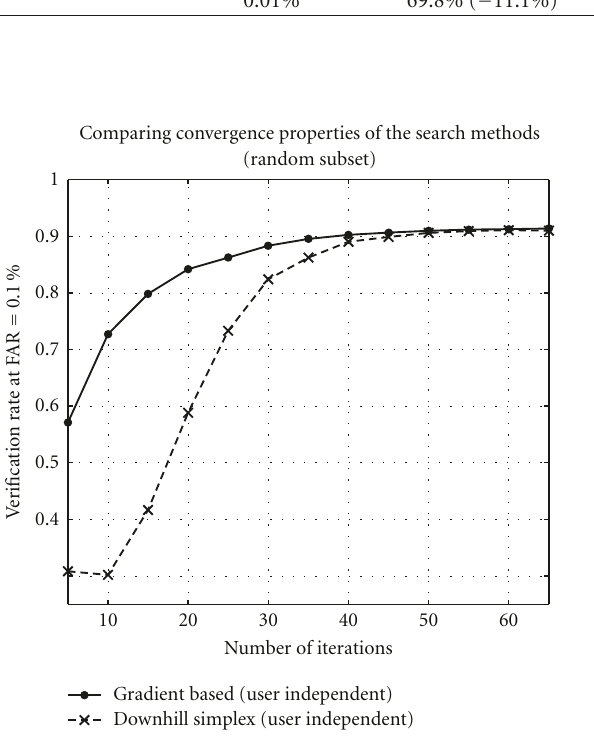
Figure 11: Comparison of the search algorithms showing the verification rates of the likelihood ratio at di ff erent number of iterations. It takes the gradient-based method 3 times more computation time to calculate the same number of iterations as the downhill simplex